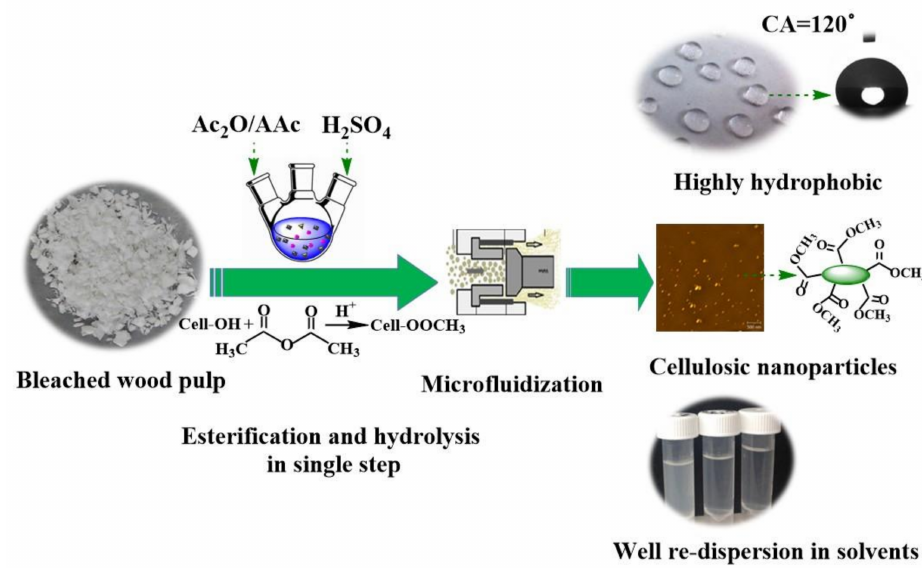
Figure 1. Schematic experimental flow diagram for producing highly hydrophobic cellulose nanoparticles (CNPs). Table 1. Experimental conditions and results of cellulose esterification. DS : degree of